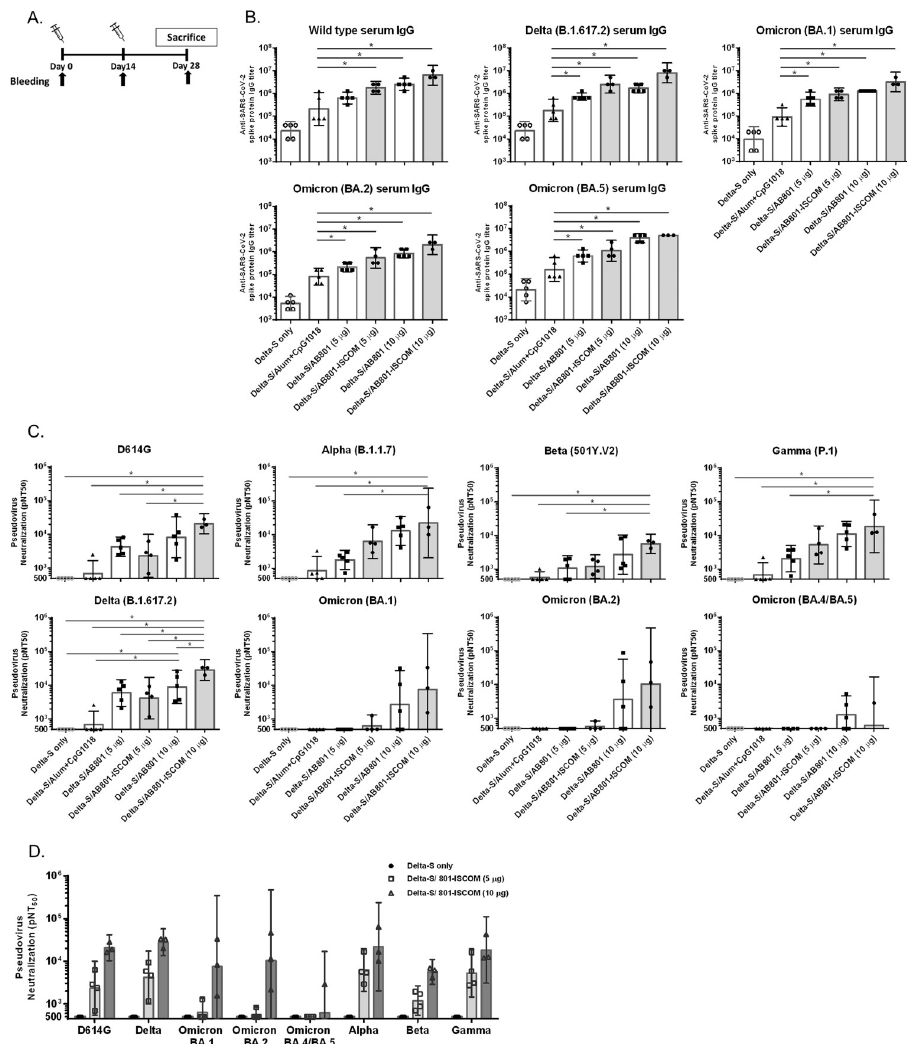
Fig 3. Evaluation of the immunogenicity of BCVax in BALB/c mice. (A) Treatment and sampling schedule. The delta S protein (10 μ g) combined with or without adjuvant candidates of aluminum hydroxide plus CpG 1018 (50 μ g plus 10 μ g, triangle), AB801 (5 or 10 μ g, square), or AB801-ISCOM (5 or 10 μ g, circle, grey bars) were immunized to BALB/c mice on day 0 and day 14. (B) anti-S protein IgG titer of wild type, delta, and omicron strains in immunized mouse serum collected on day 28. (C) Neutralizing antibody titers of sera of immunized mice against SARS-CoV-2 pseudoviruses D614G, B.1.1.7, 507Y.V2, P.1, B.1.617.2, BA.1, BA.2, and BA.4/5 variants. Bars indicate the geographic mean titer (GMT), and the error bars represent 95% confidence intervals. Data were analyzed using one-way ANOVA. (D) pNT50 value of AB801-ISCOM groups against D614G, B.1.1.7, 507Y.V2, P.1, B.1.617.2, BA.1, BA.2, and BA.4/ BA.5 variants. ( � p <